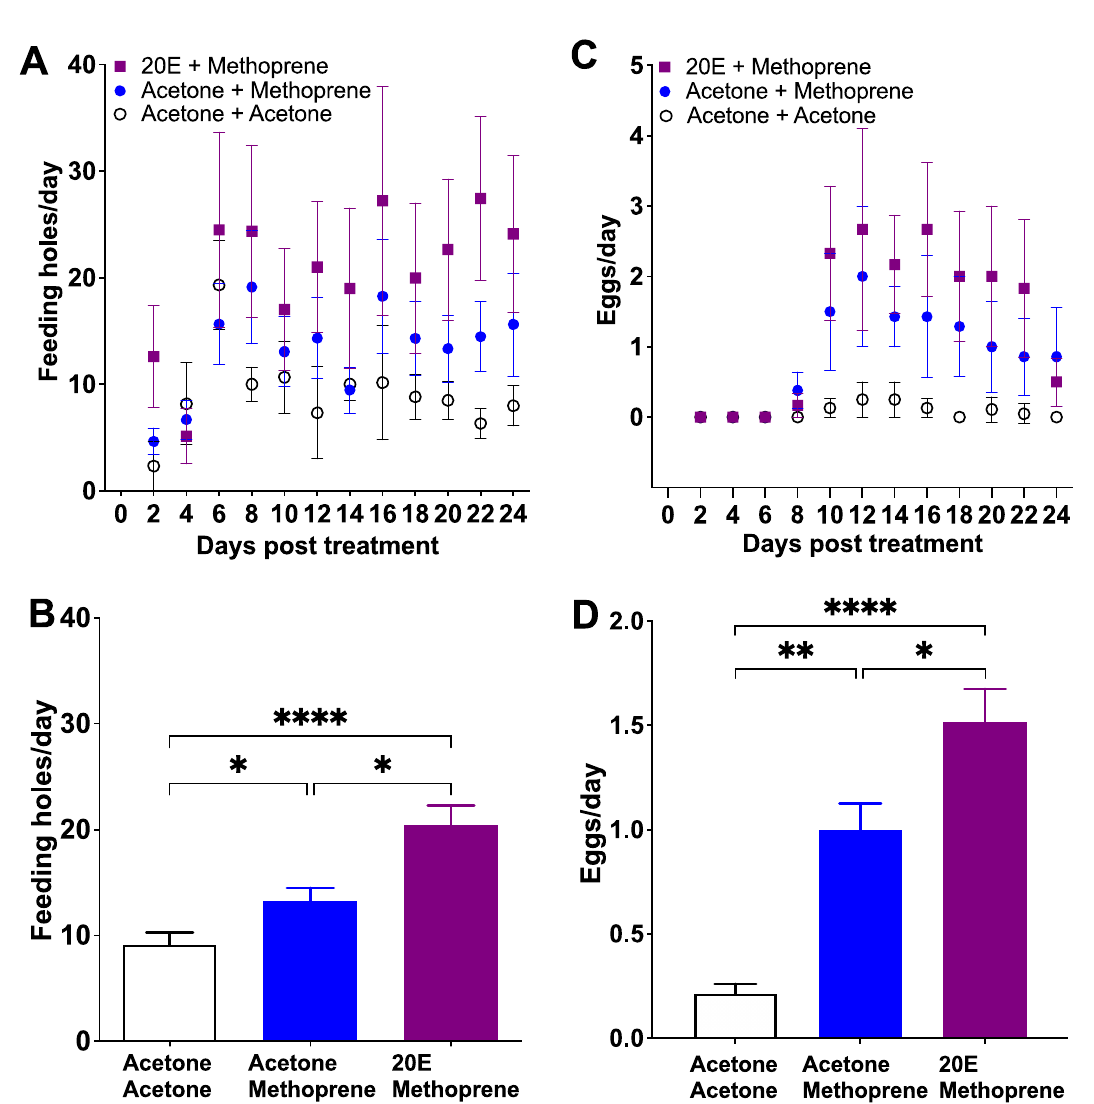
Figure 3. The effect of 20E and methoprene on feeding holes ( A , B ) and eggs ( C , D ) of female C. basicorne (mean ± SE). Day indicates the end of each two-day exposure period; acetone + acetone (white dot); acetone + methoprene (blue dot); 20E + methoprene (purple square); *: p < 0.05; **: p < 0.01; ****: p < 0.0001.